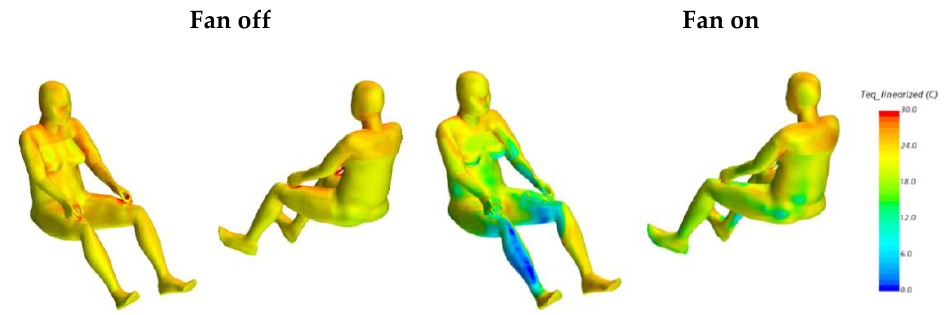
Figure 20. Local T eq values on the manikin from two perspectives with left fan off and right fan on. From these T eq values, a global PMV and PPD index can be calculated, such as the previous generic cubic room study. The PMV value yields a positive, neutral comfort level with a deactivated fan and a tendency to a negative slightly cold comfort level with an activated fan (Table 6). Table 6. Global PMV, PPD, and DTS values for the environmental chamber. PPD with T eq DTS Final Value PMV with T eq (%)